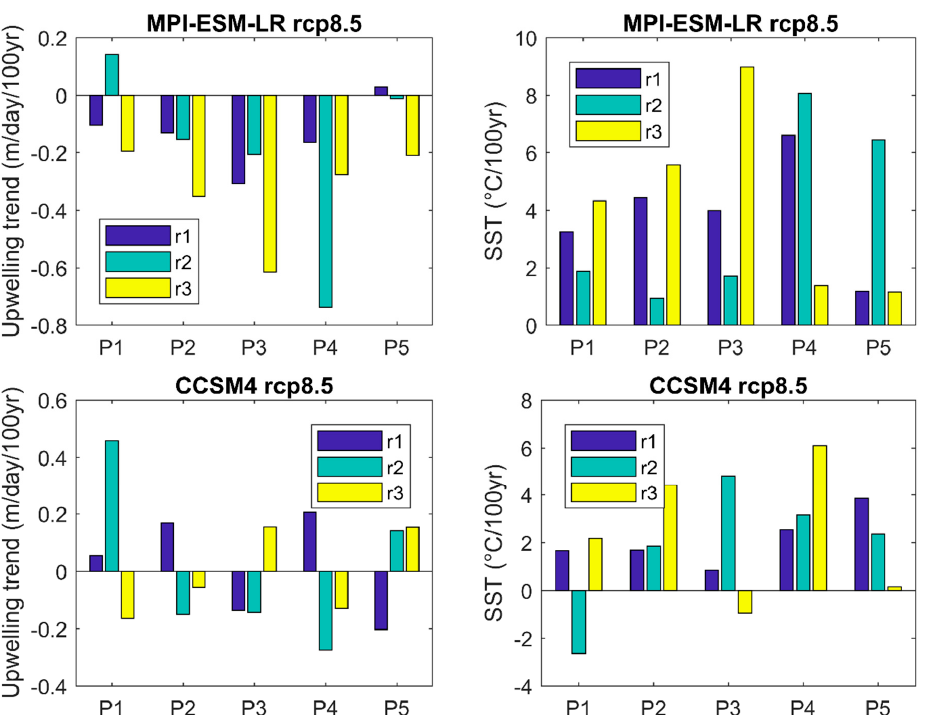
Figure 11. Decadal trends for the future RCP 8.5 scenario in the MPI-ESM-LR (upper) and CCSM4 (lower) models for upwelling ( left ) and SST ( right ). P1 to P5 represent the 19-year periods from 2006 to 2100.